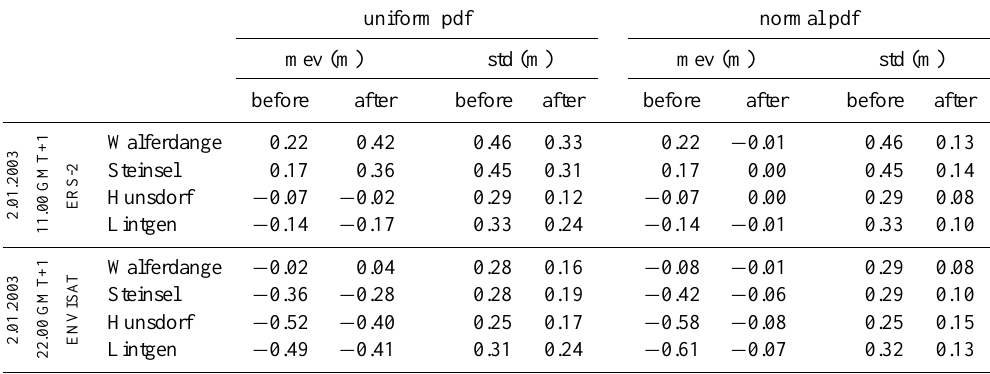
Table 2. Idem Table 1, but considering the local weighting variant of the PF. uniform pdf normal pdf mev (m) std (m) mev (m) std (m) before after before after before after before after